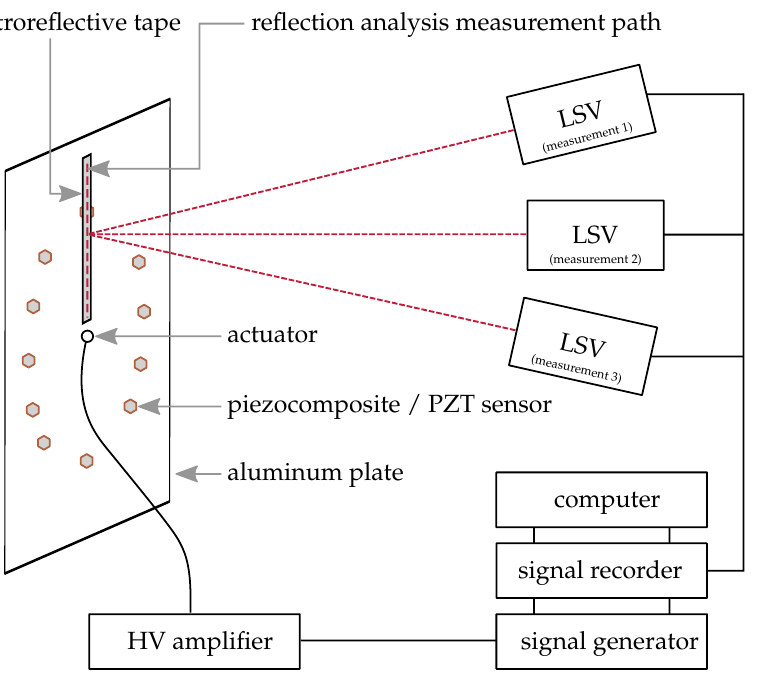
Figure 5. Experimental setup of the three-dimensional scanning laser Doppler vibrometry technique for separate measurement of the in-plane and out-of-plane components of the wave propagation to determine the GUW reflections at the applied